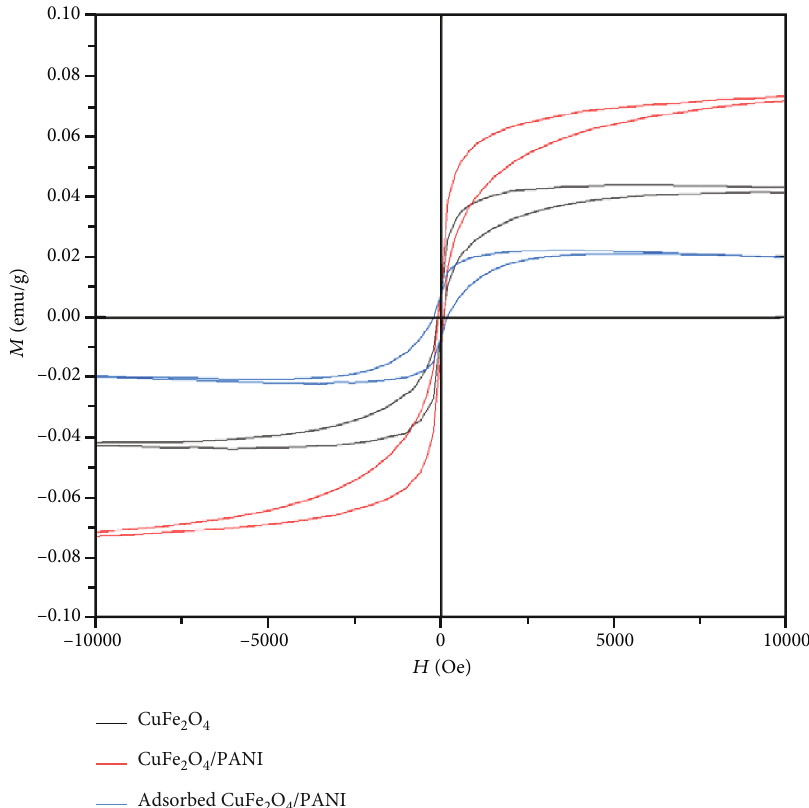
Figure 6: VSM curves of CuFe